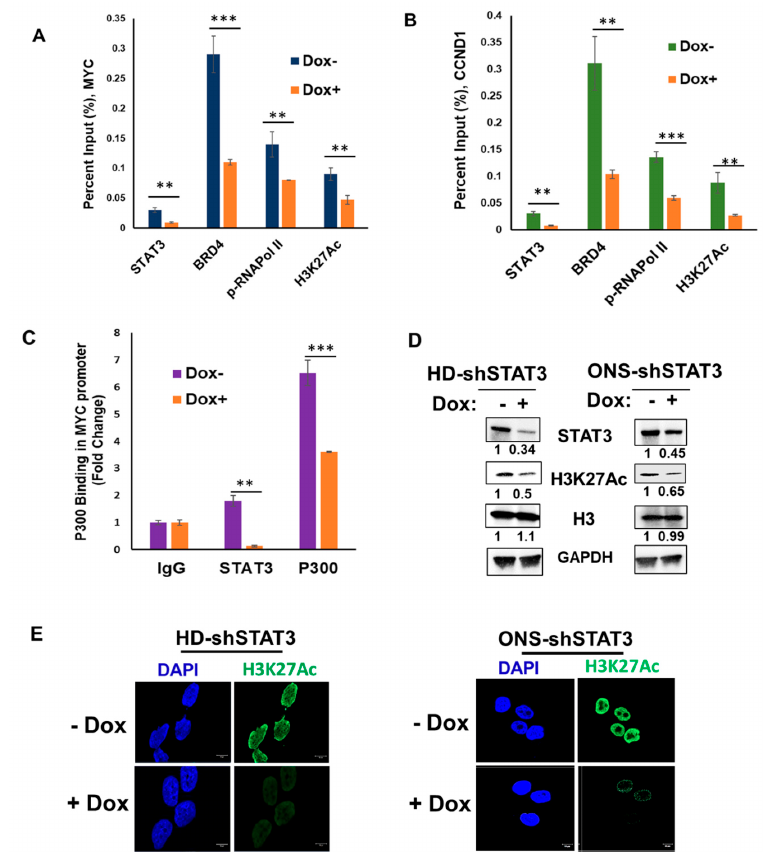
Figure 4. STAT3 KD attenuates histone modification and RNA Pol II recruitment on target gene promoters. MB cells were treated with 0.5 µg/mL Dox prior to crosslinking with formaldehyde. STAT3, BRD4, pSer2-RNAPol II, and H3K27Ac binding to the MYC ( A ) and CCND1 ( B ) promoters were demonstrated by ChIP-qPCR. IgG Ab was used as a negative control and data are presented as percent (%) input; ** p < 0.01, *** p < 0.001. ( C ) Cells were treated the same as before; binding of STAT3 and p300 on the MYC promoter are presented as fold change compared to IgG; ** p < 0.01, *** p < 0.001. ( D ) HD-shSTAT3 and ONS-shSTAT3 MB cells were treated either with or without Dox and WCEs were analyzed for H3K27Ac expression. Total H3 and GAPDH were used as control. ( E ) Cells were grown in coverslips and were treated as in ( D ) and an immunofluorescence (IF) experiment was performed to detect the levels of H3K27Ac. Nuclear staining is shown by DAPI. The uncropped bolts are shown in Supplementary Materials file